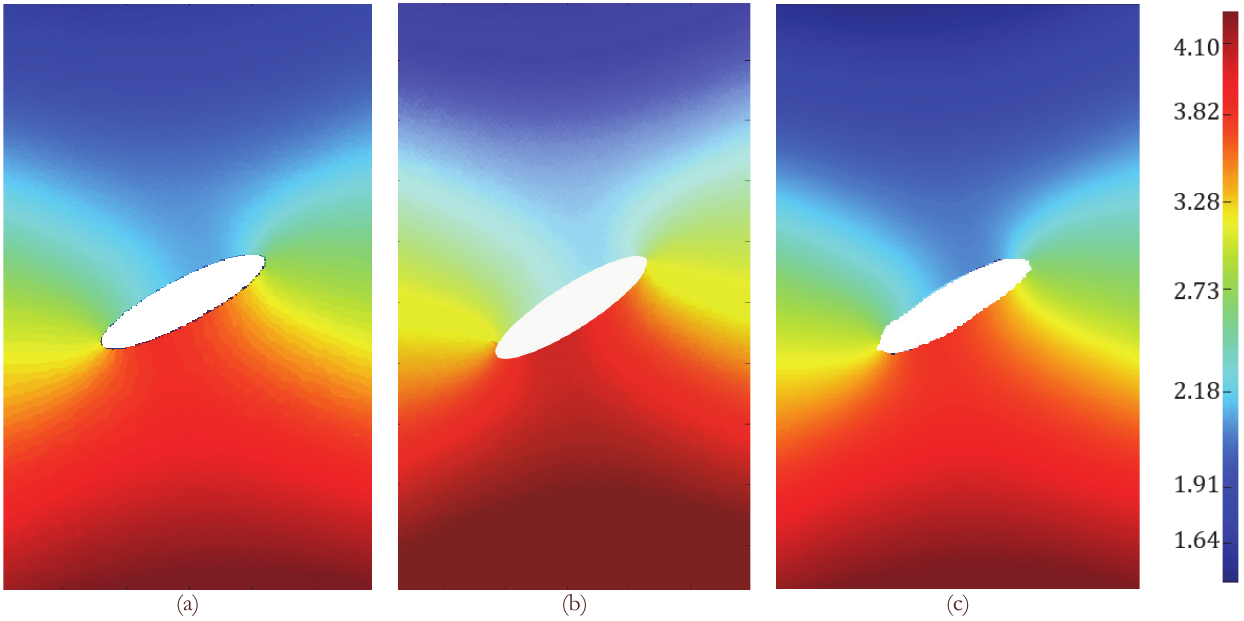
Figure 5: Map of the displacement along X axis[mm] of the elliptical hole with an aspect ratio 0.1, 60° inclined with respect to the load axis. Results computed, in order of appearance, with (a) LSM, (b) SGM, (c)